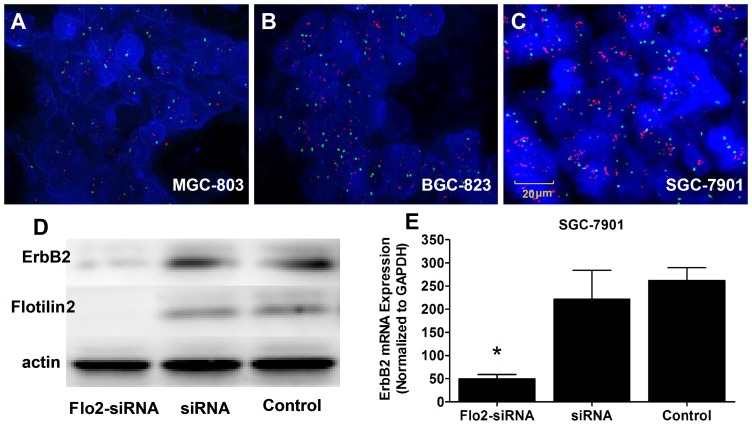
Knockdown of flotillin-2 resulted in a stronger reduction of erbB2.Amplification of HER2 gene was determined by FISH. HER2 gene amplification in a cluster pattern (red) was observed in (A) MGC-803, (B) BGC-823 and (C) SGC-7901 gastric cancer cells, HER2 over expression in human SGC-7901 cell. (D) Western blot analysis and (E) Quantitative real-time PCR were accessed for erbB2 and flotillin2 in SGC-7901 cell line after knockdown of flotillin-2. The expression status of flotillin2 is highly concordant with that of erbB2, siRNA was blank vector, β-Actin was used as internal control.